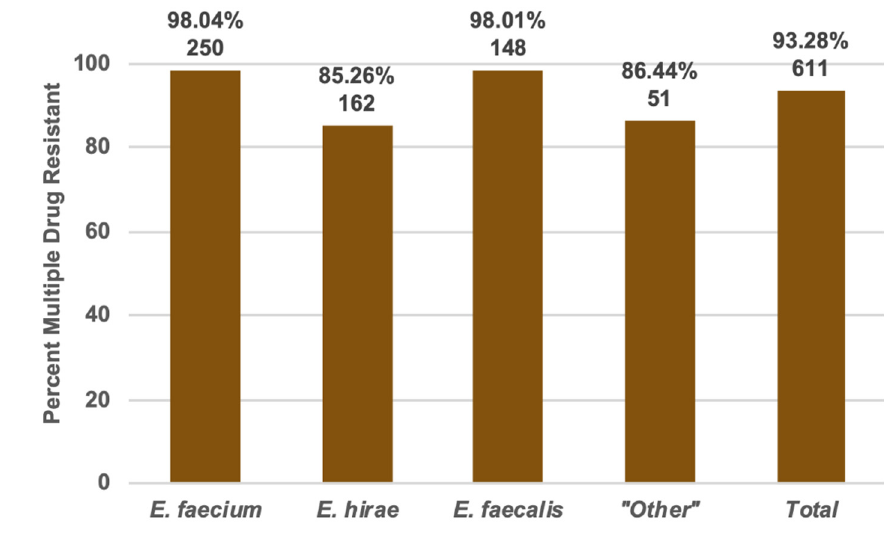
Figure 2. Multiple drug resistance as percent of isolates from each species and of total that were multiple drug resistant.